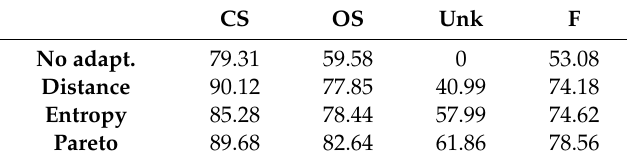
Table 4. Average performances obtained for the VHR